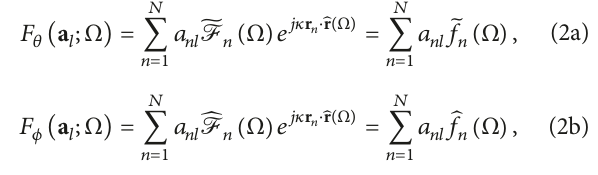
algorithm. Section 4discusses the numerical results. Section 5 remarks the most relevant